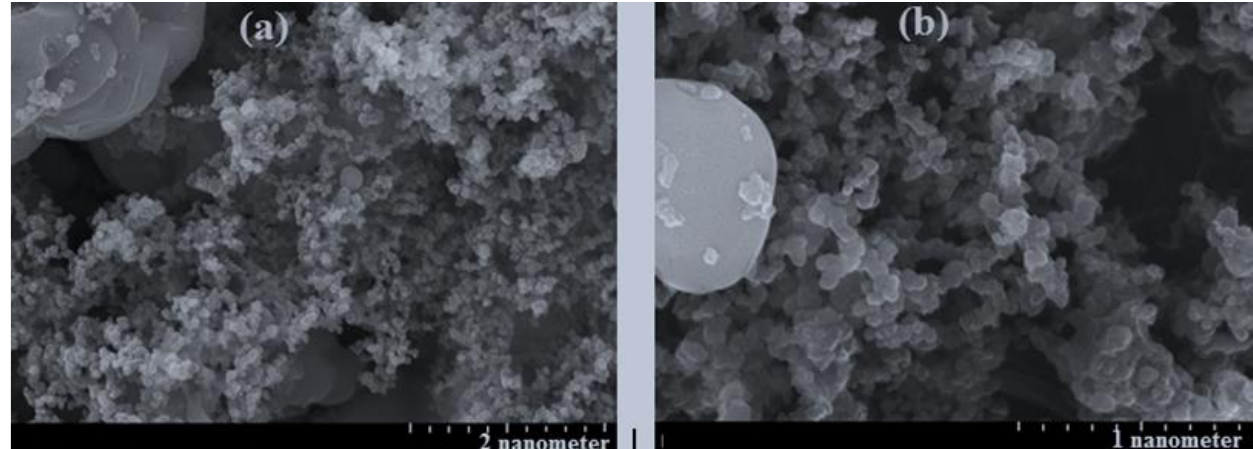
Figure 3. The SEM of four cathode materials for four samples including ( a ) = sample 17